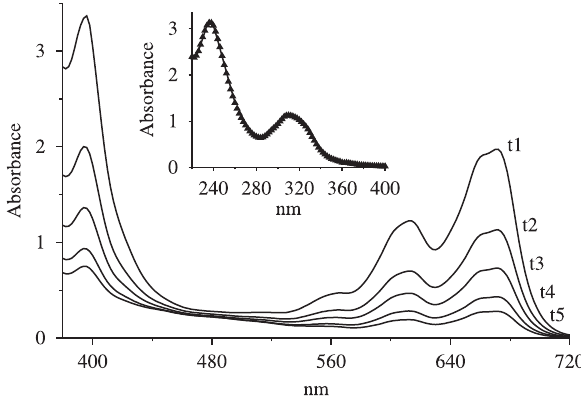
Figure 2. Reaction of NTCDA with Al and OH – = 500 mg, in 20 mL H O-EtOH (15:5 mL). UV-VIS spectrum from t1 to t5 timespan was 2 hours 2 with 25 minutes interval. Insert: naphthalene 1,4,5,8-tetracarboxylic acid UV-VIS spectrum with maximum absorption peaks at λ absmax = 230 and 310